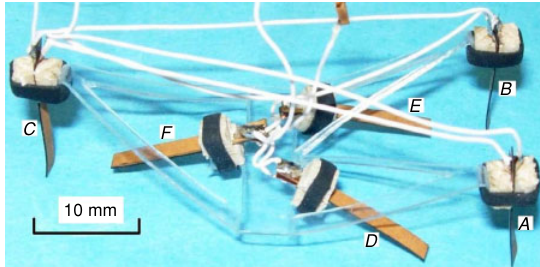
Figure 7 Outline of Walker-1.